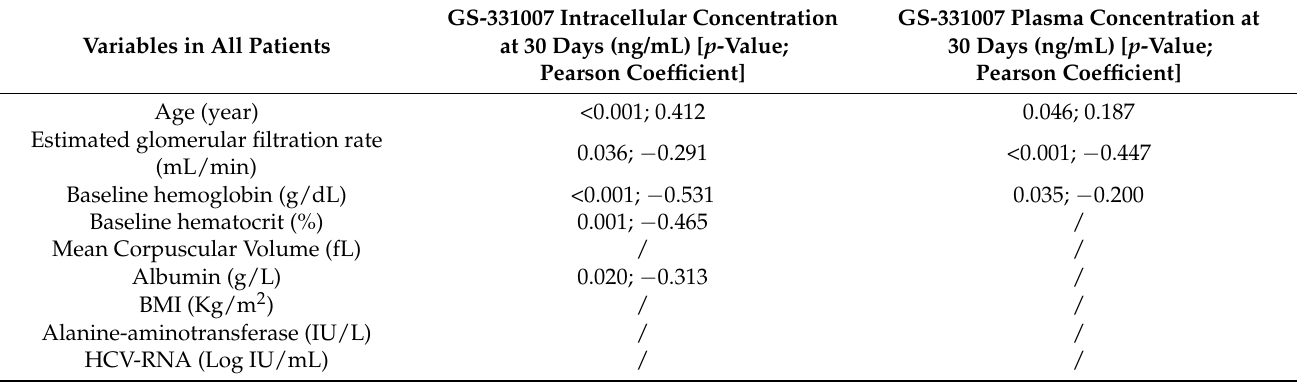
Table 2. Associations of GS-331007 intracellular (IC) and plasma levels with demographic and hematochemical parameters in all patients.